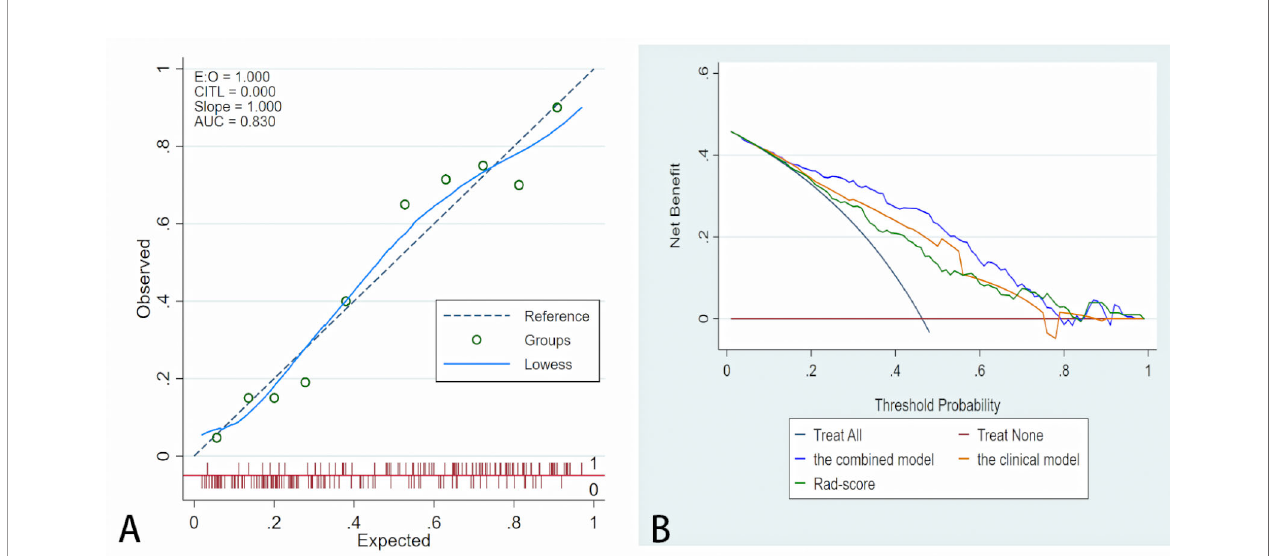
FIGURE 4 | Fit and usefulness evaluation of the nomogram. (A) Calibration curve of the nomogram. The calibration curve depicts the calibration of the model in terms of the agreement between the predicted risk of TDs (x axis) and observed outcomes of TDs (y axis). The blue solid line represents the performance of the nomogram (Note: a closer fi t to the diagonal dotted line represents a better prediction). (B) The decision curve demonstrates that the model obtains more bene fi t than “ treat all ” , “ treat none ” , Rad-score, and the clinical model, when the threshold probability is in the range of 18% to